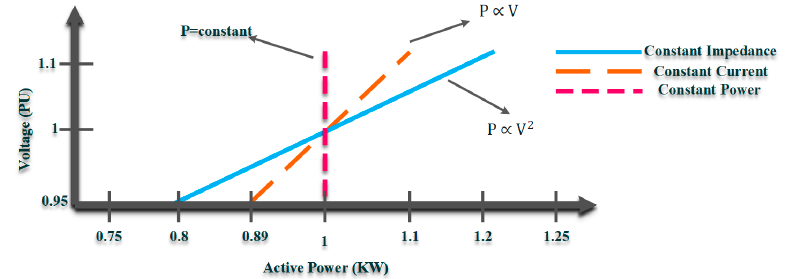
Figure 1. Power dependency on supply voltage for a 1 kW load using ZIP model [15].